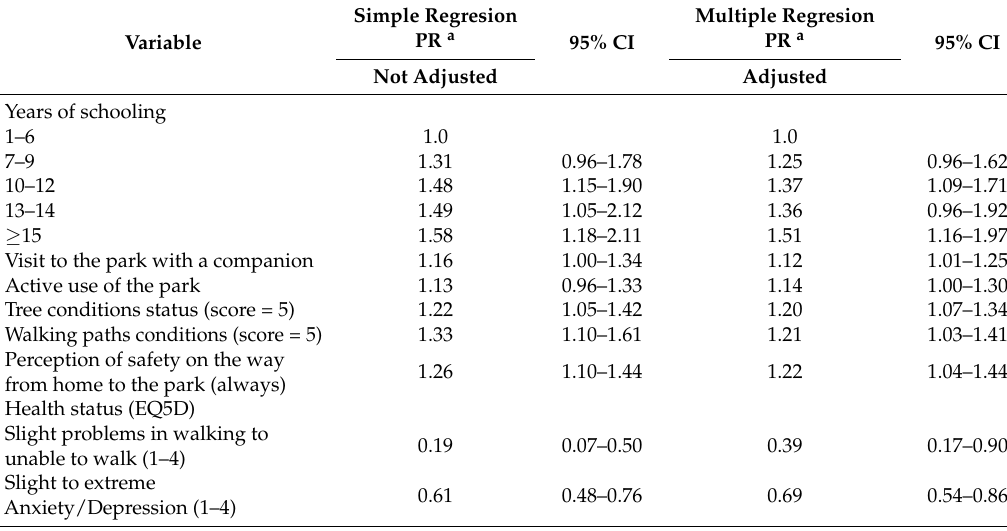
Table 6. Associated factors to quality of life in park users (N = 1357, Link test p :